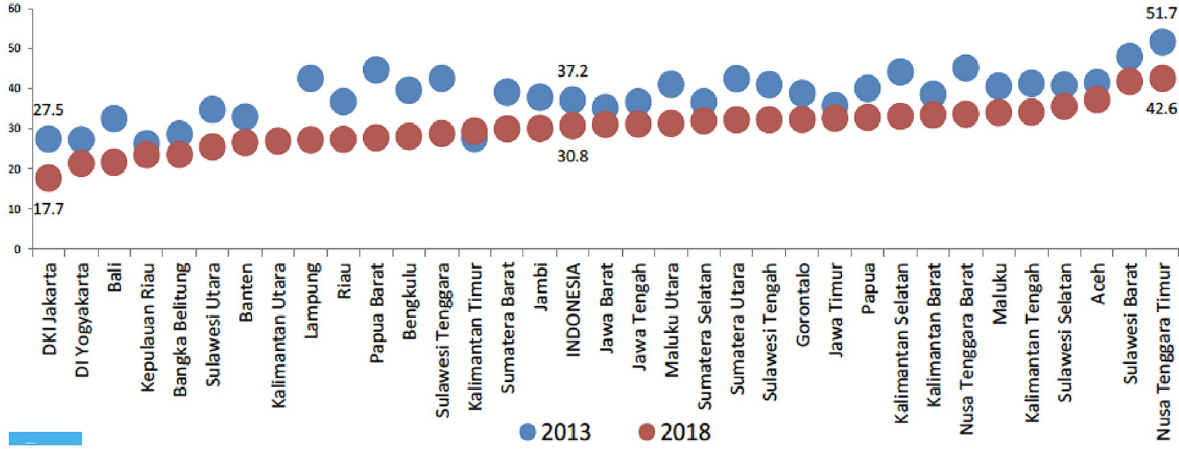
Fig 1. Stunting prevalence across provinces in Indonesia. Source: Basic Health Survey (2018).